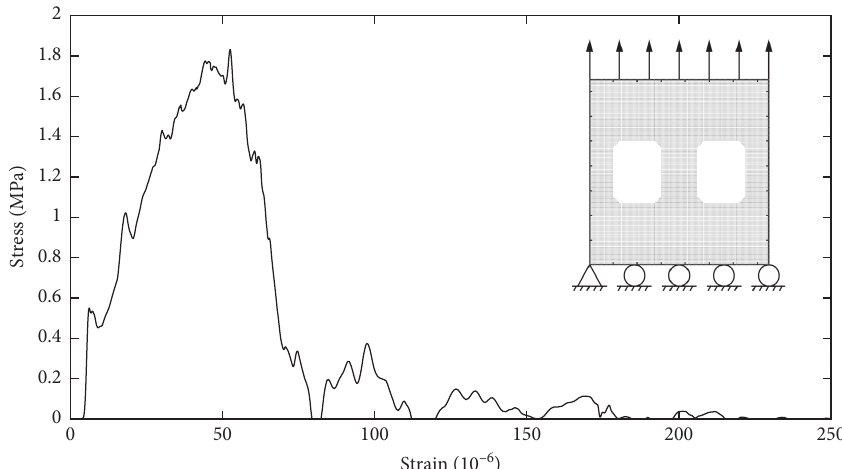
Figure 9: Loading scheme of the double-aggregate specimen and its stress-strain